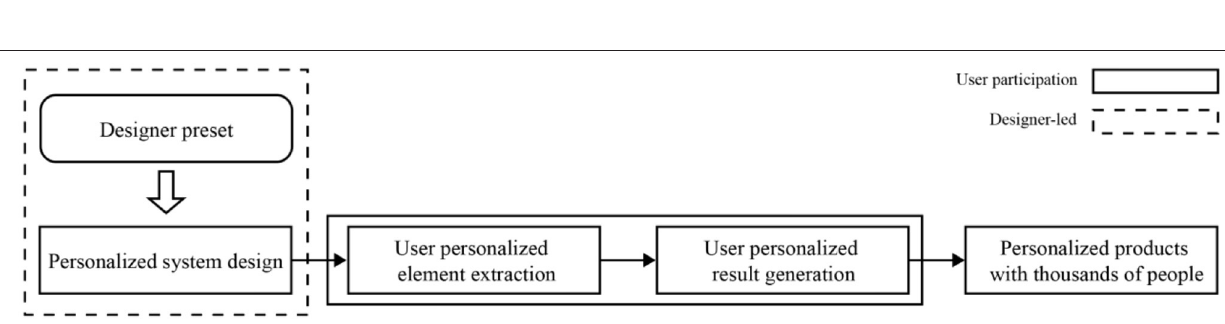
FIGURE 11 | Traditional personalized design approach and role engagement.